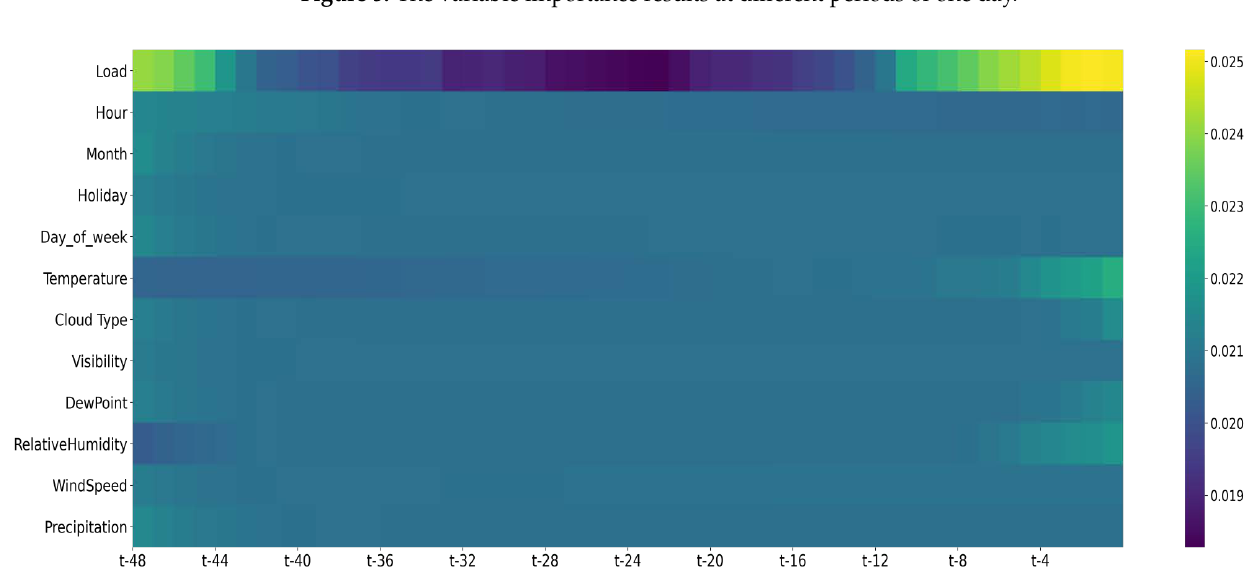
Figure 5. The variable importance results at different periods of one day.